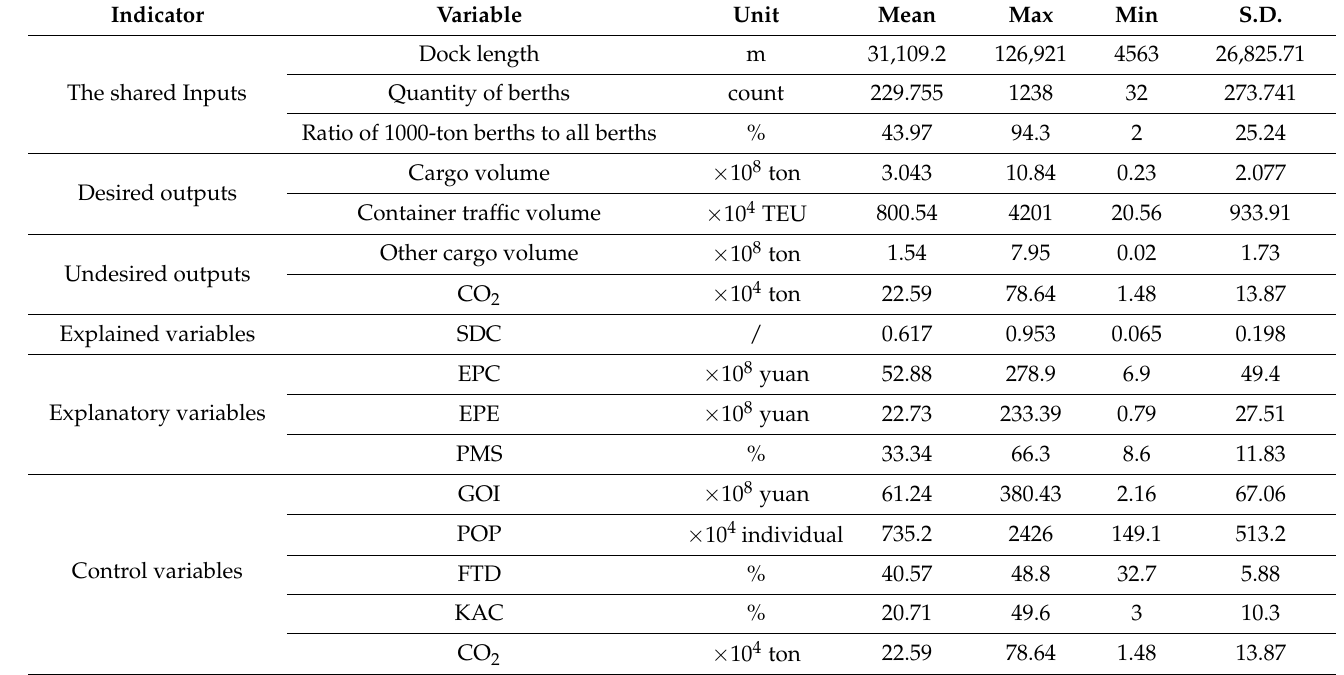
Table 2. Descriptive statistical data of the variables.